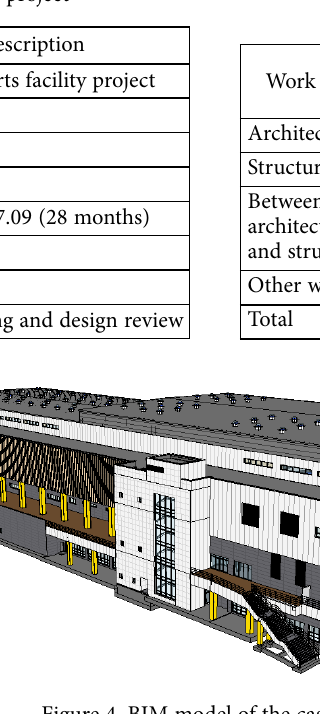
Figure 4. BIM model of the case